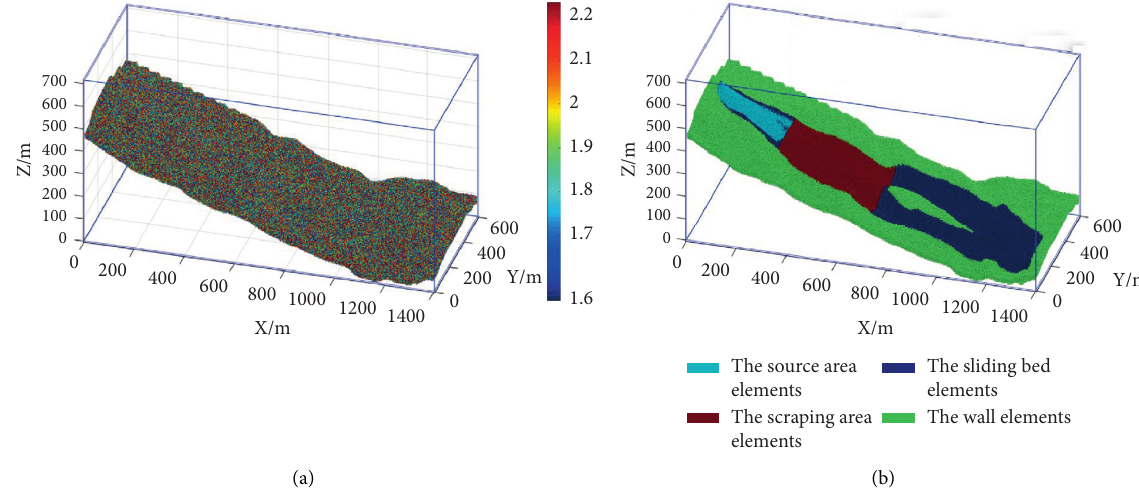
Figure 6: The discrete element model of the Shuicheng landslide. (a) Initial model. (b) Grouped model. Table 1: Macro- and micromechanical parameters of the material in the Shuicheng